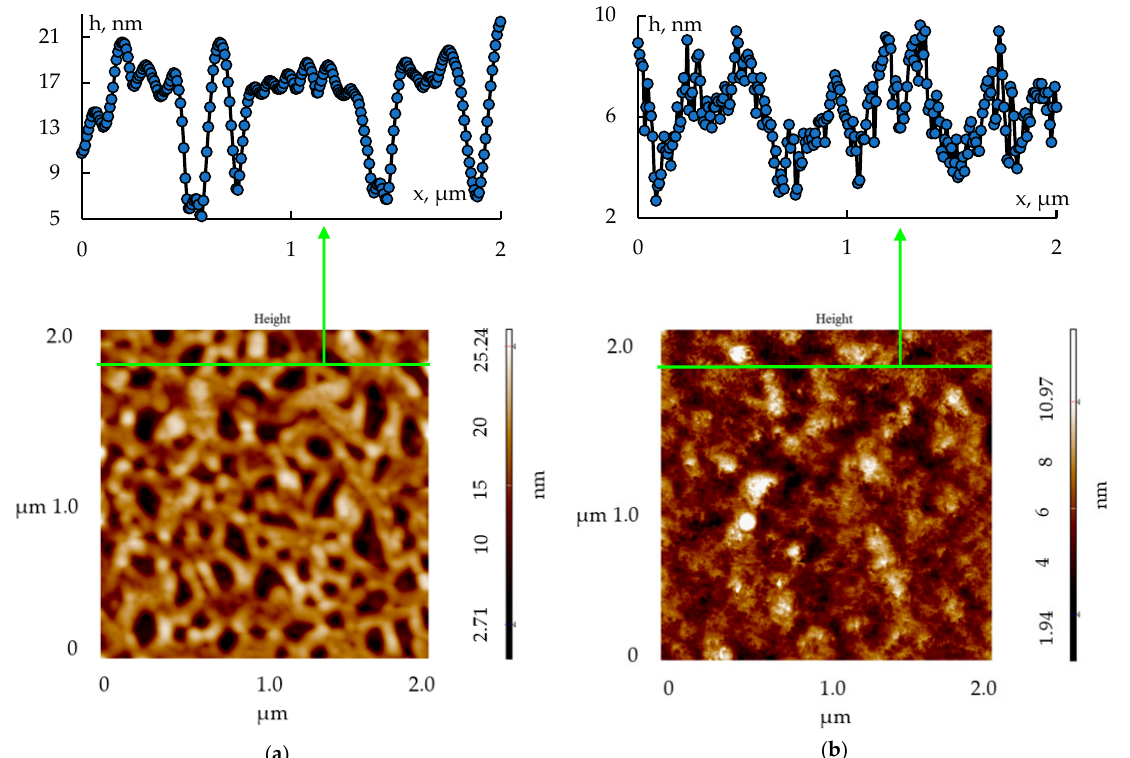
Figure 14. Typical atomic force microscopy images (image size 2 µm × 2 µm) of porous nanocom- posites and their profiles (along the green lines): ( a ) a two-component system, SiO 2 –SnO 2 ; ( b ) a three-component system, SiO 2 –SnO 2 –In 2 O 3